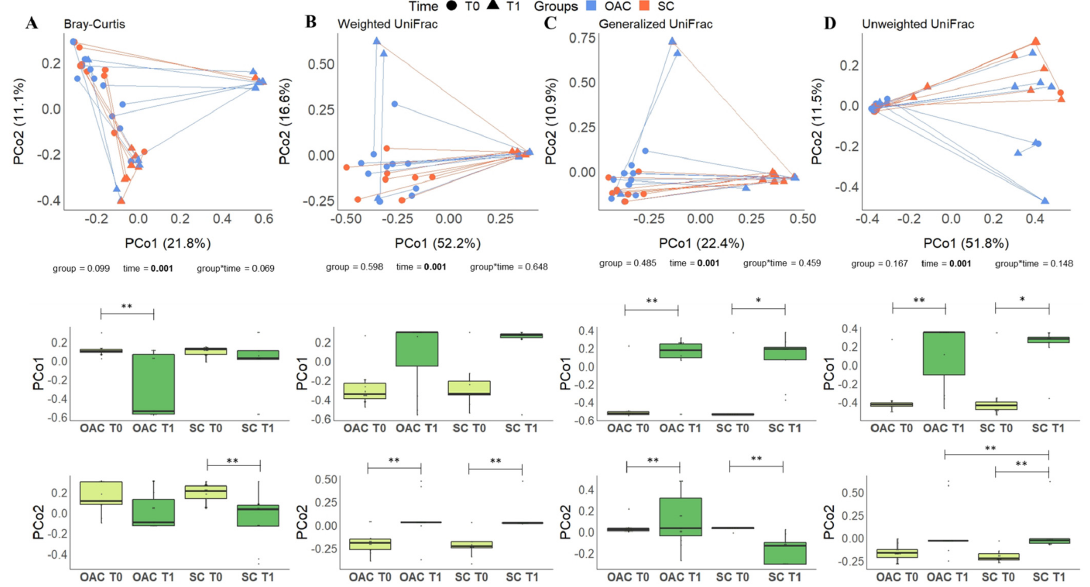
Figure 6. Beta diversity distances (Bray–Curtis—( A ); Weighted UniFrac—( B ); Generalized UniFrac—( C ) and Unweighted UniFrac—( D )) comparing OAC group (blue) to SC group (red) between baseline (T0—circles) and after the protocol (T1—triangles); * Indicates a p value between 0.01 and 0.05; ** Indicates a p value between 0.01 and 0.001. Legend: OAC (Oropharyngeal Administration of Colostrum); SC (Standard Care).